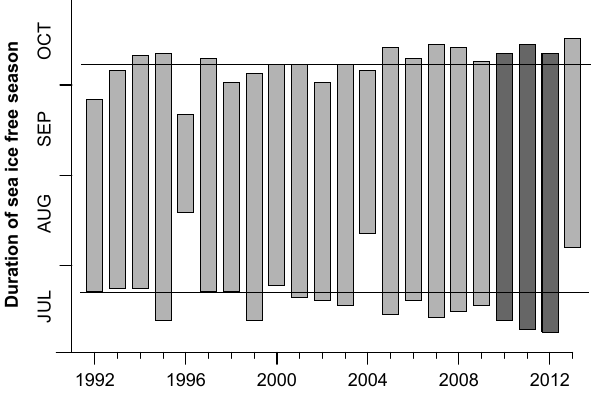
Figure 18. Seasonal duration of the sea-ice-free period 100km around Muostakh Island in the Buor Khaya Gulf. Top and bottom horizontal lines indicate mean start (21 July) and end (8 October) days according to the reference time period 1992–2013 with mean seasonal duration of 81 days.